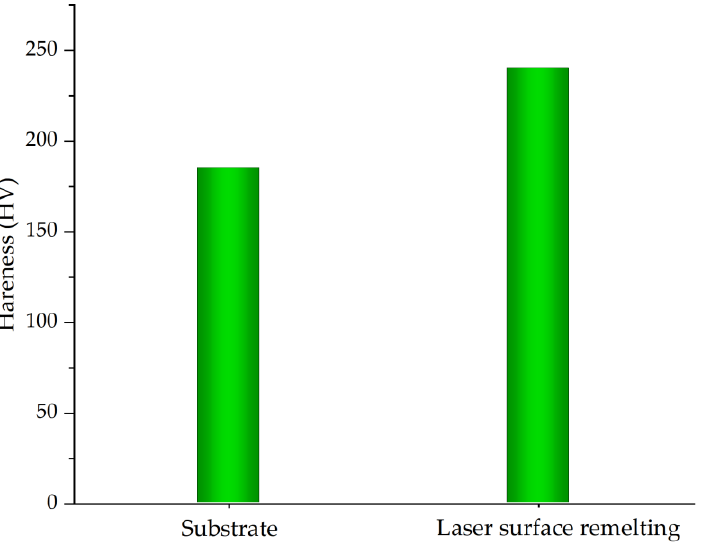
Figure 12. Surface hardness of stainless steel before and after laser remelting.